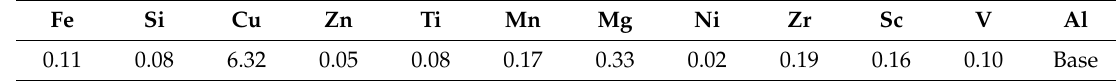
Table 1. Chemical composition of AA2519-T62 extrusion.